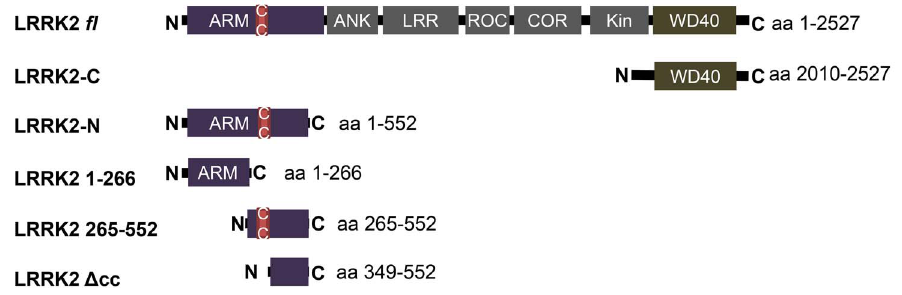
Figure 1. LRRK2 constructs used in this study. ARM: armadillo repeats; ANK: ankyrin repeats; LRR: leucine rich repeats; ROC: Ras of complex; COR: C-terminal of ROC; Kin: kinase domain; WD40: WD40 domain; c/c: coiled coil motif (aa 319–348).